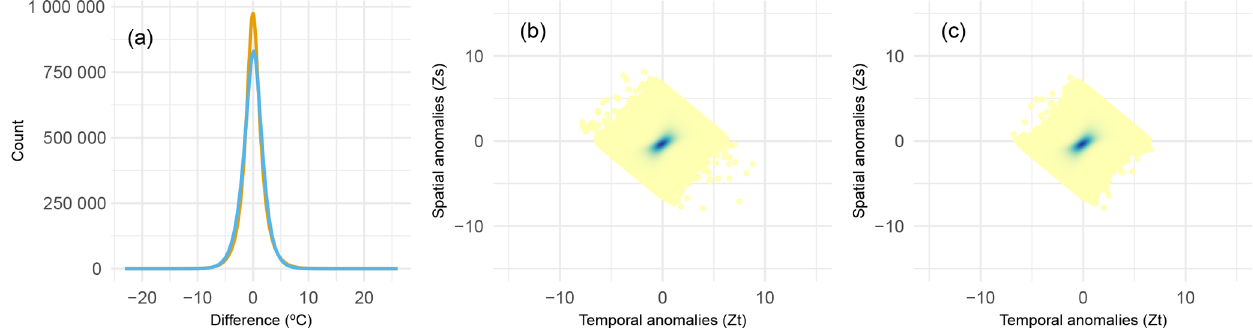
Figure 10. Comparison of observations and estimates in the final dataset. (a) Maximum (orange line) and minimum (blue line) temperature differences between observations and estimates; (b, c) temporal anomalies (Zs) vs. spatial anomalies (Zs) of the final dataset.